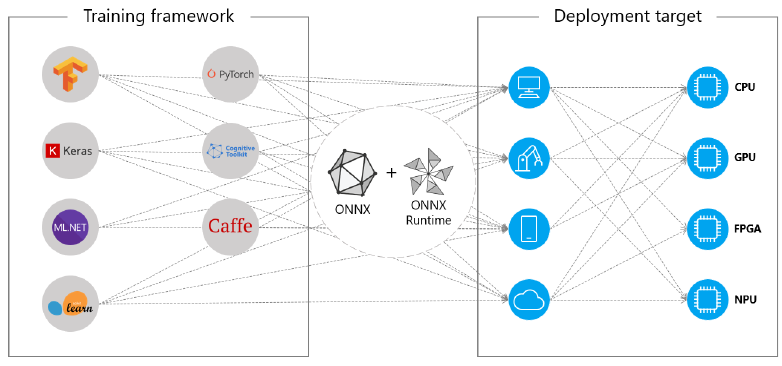
Figure 3. Interoperability of different frameworks by using